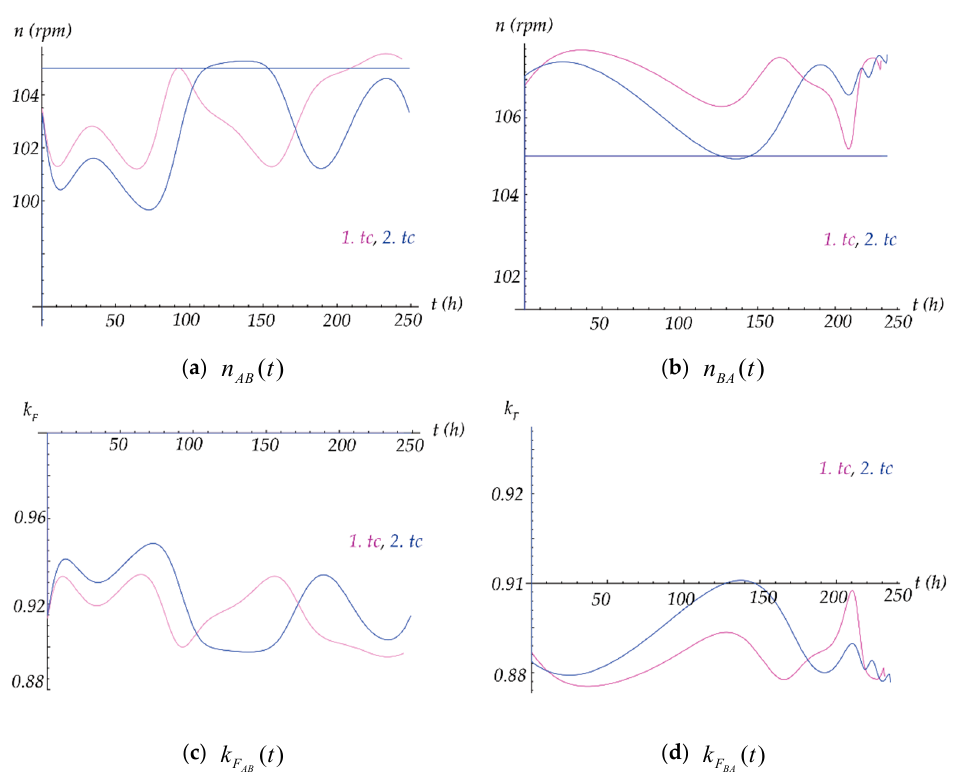
Figure 5. Unsteady balanced items of MDE for navigation in 1st and 2nd transport cycle.